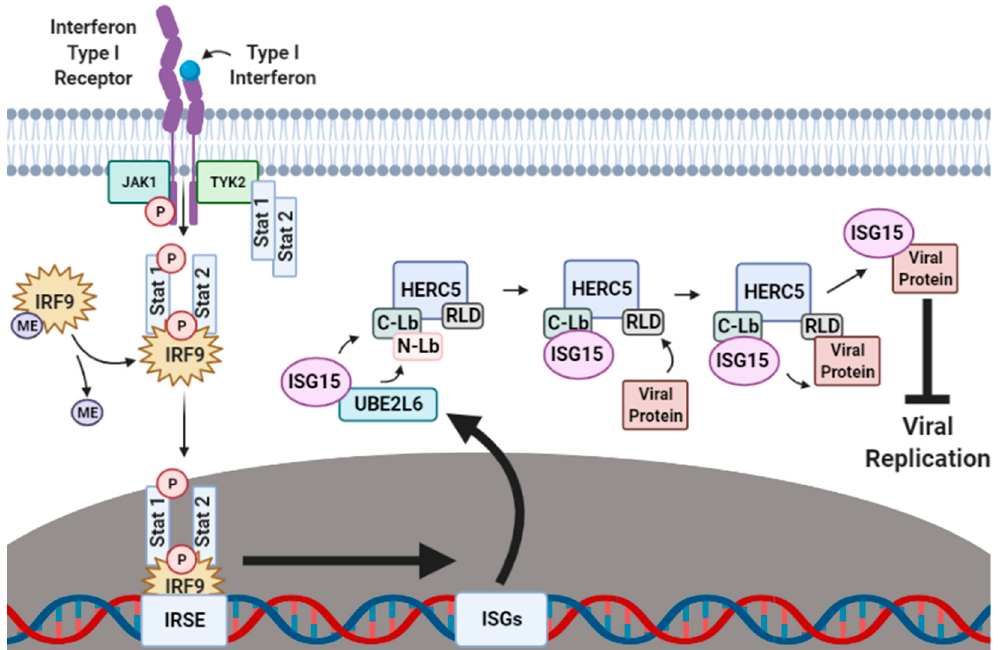
Figure 1. Interferon-induced ISGylation of viral proteins. During the initial stages of infection, cellular IFN- α / β surface receptors are bound by IFN- α / β -specific ligands that expose receptor phosphorylation sites to the cytoplasm. Janus kinase 1 (JAK1) and tyrosine-protein kinase 2 (TYK2) phosphorylate exposed cytoplasmic IFN- α / β receptor sites, thus recruiting the nuclear transcriptional regulators signal transducer and activator of transcription proteins 1 and 2 (STAT1 and STAT2) to also be phosphorylated by TYK2. In the cytoplasm, phosphorylated STAT1 and STAT2 form a ternary complex with methylated IRF9 which is then demethylated to signal for the migration of the STAT1–STAT2–IRF9 (SSI) complex to the nucleus. Upon nuclear entry, the SSI complex binds to the ISG promoter region interferon-stimulated response element (ISRE) to upregulate the transcription of several hundred ISGs, including ISG15, UBE1L, UBE2L6 and HERC5. Translated UBE1L, UBE2L6 and HERC5 proteins are subsequently targeted to the perinuclear regions of the cytoplasm where they work in tandem to charge, transfer and attach ISG15 onto respective viral protein substrates to inhibit viral stability, transport and reassembly. ME, methylation. This figure was created with Biorender™.